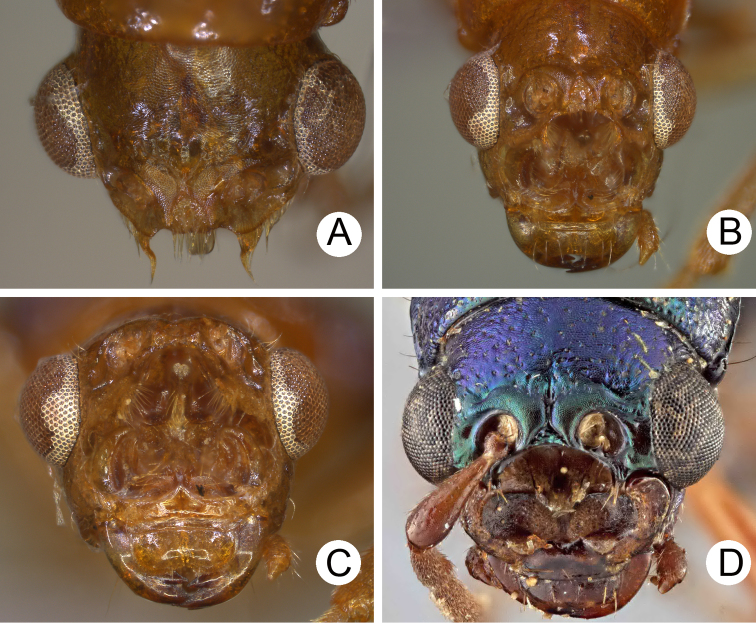
Heads of males of Pseudotheopea
aeneipennis and P.
azurea. AP.
aeneipennis, dorsal view B Same, dorsofrontal view C Same, front view DP.
azurea, holotype, dorsofrontal view.